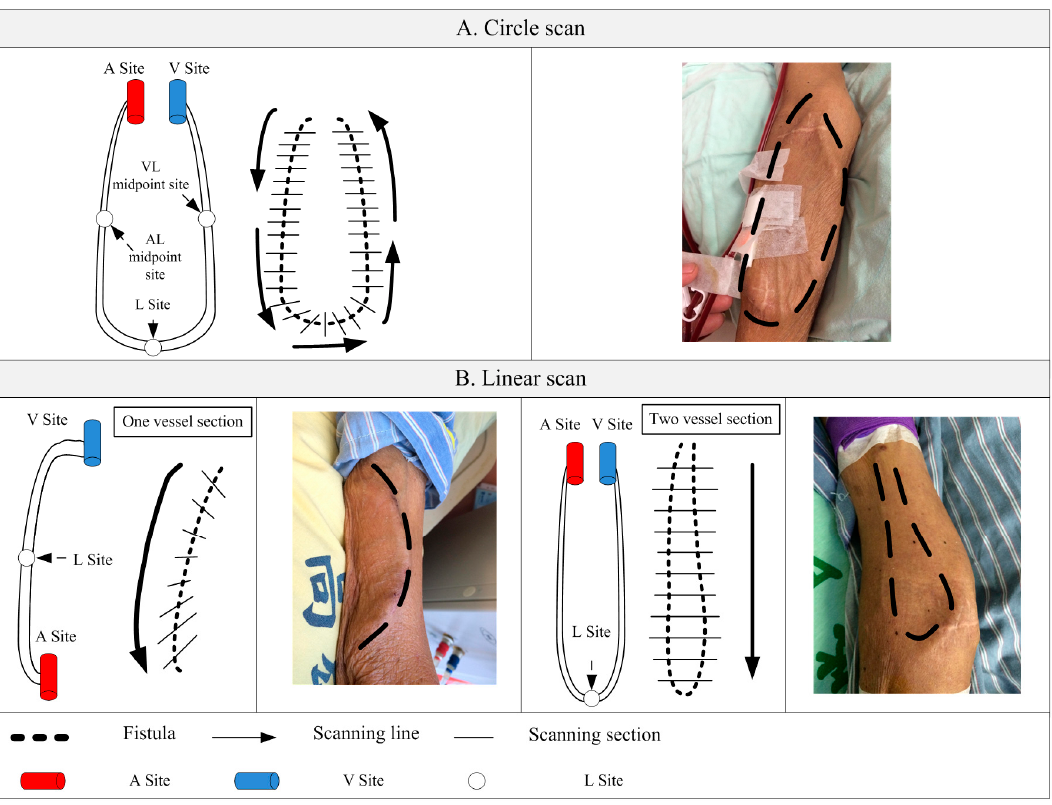
Figure 4. Two scanning modes ( A ) circle and ( B ) linear scan.